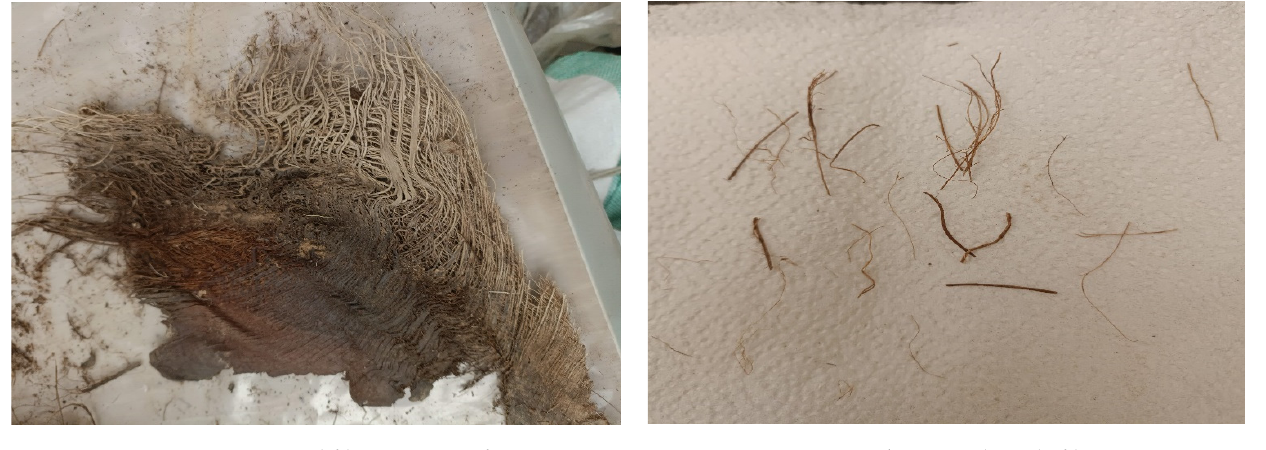
Figure 4. Date palm fiber. Table 2. Properties of DPF (1).